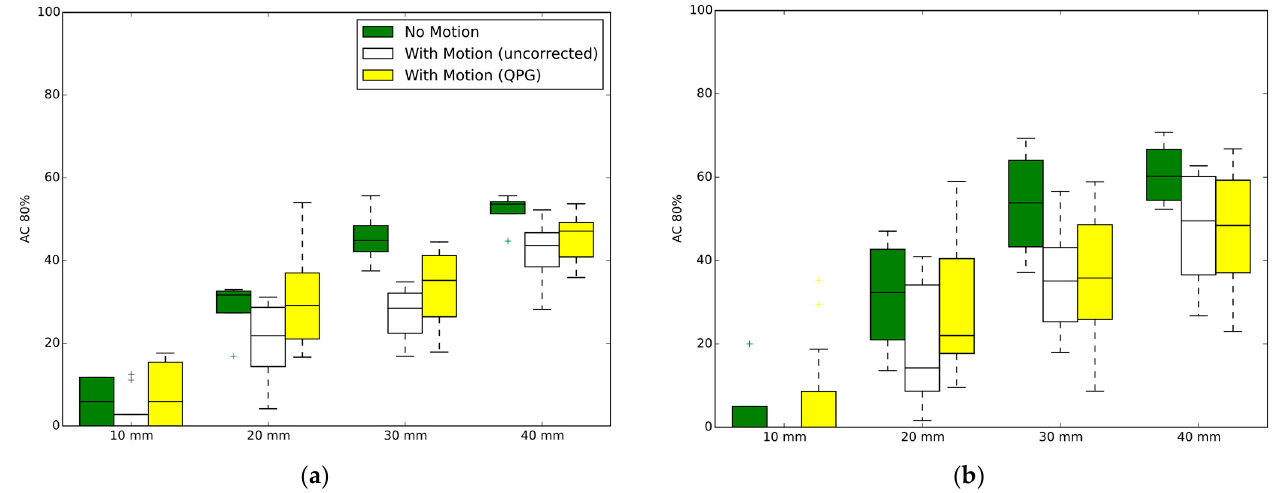
Figure 5. AC 80 from different sphere diameters. Each figure part shows the results for no motion, and when motion is present (10–15 mm amplitudes) either with or without quiescent period gating. Combined datasets from four phantom experiments on each scanner. ( a ) Discovery 710 (BPL reconstruction); ( b ) Biograph mCT.